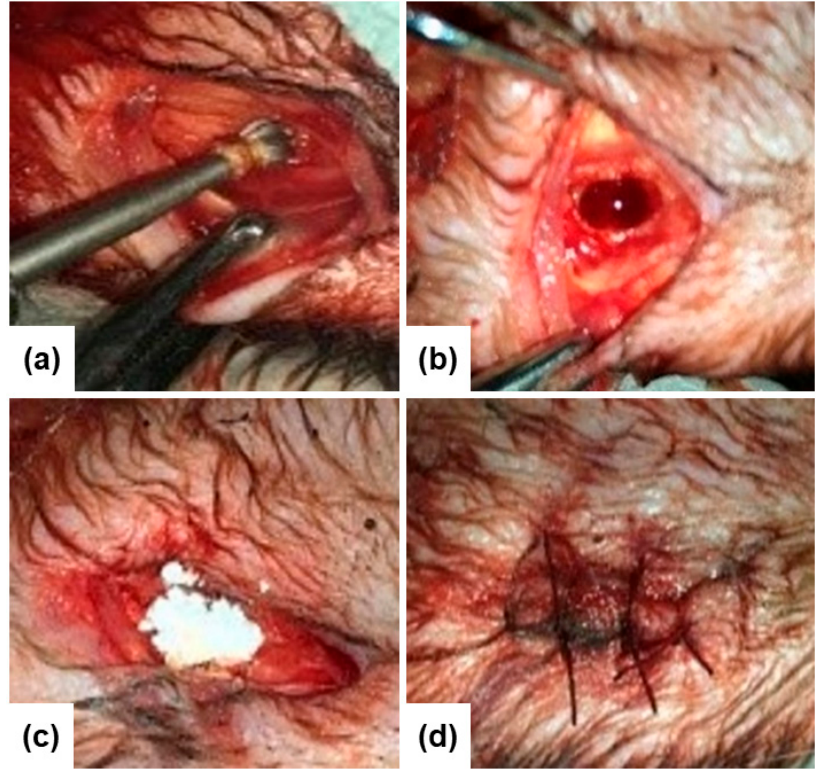
Figure 2. Surgical method to access femoral diaphysis region ( a ), bone defect already created ( b ), bone defect filled with bioactive glass beads ( c ), the incised hole is sewed up ( d ). The X-ray images of the defect in the animal of the control and experimental group after surgery were obtained using DIGIMED Intraoral Digital Dental X-ray Sensor DVS- 100.